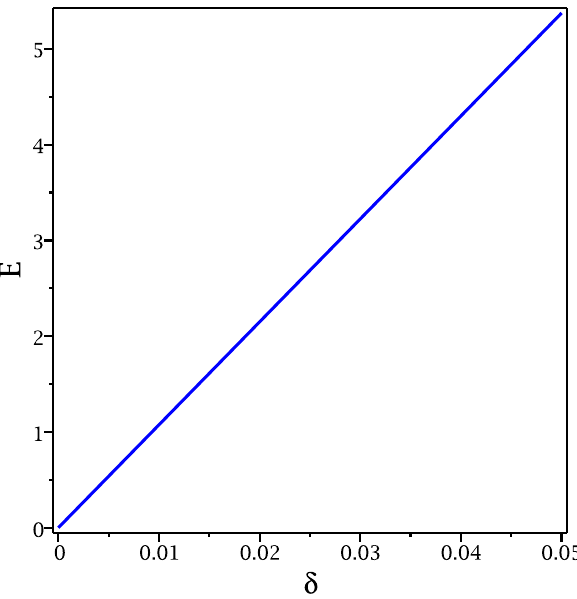
Fig. 8 The entropy S vs thickness δ . We have chosen σ 0 = 4, D = 1, A 0 = 1, (cid:8)(ε) = − 1, m = 2 and H (ε) = 1 .